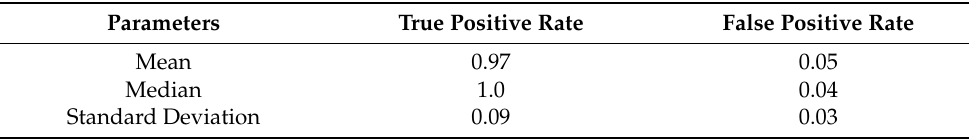
Figure 5. Mixed NMR spectra (black) and the predicted components (color coded) for Mixture Numbers 5 ( A ), 23 ( B ), 35 ( C ), and 20 ( D ), containing 3, 4, 5, and 6 molecules, respectively. Table 2. Summary of the automated molecular mixture analyzer’s performance for the augmented NMR